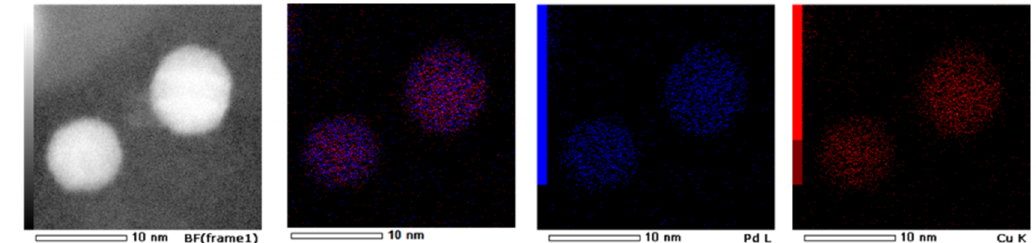
Figure 4. A representative set of EDS mapping data showing the elemental distribution across the nanoparticle for a sample of Pd 20 Cu 80 nanoparticles.